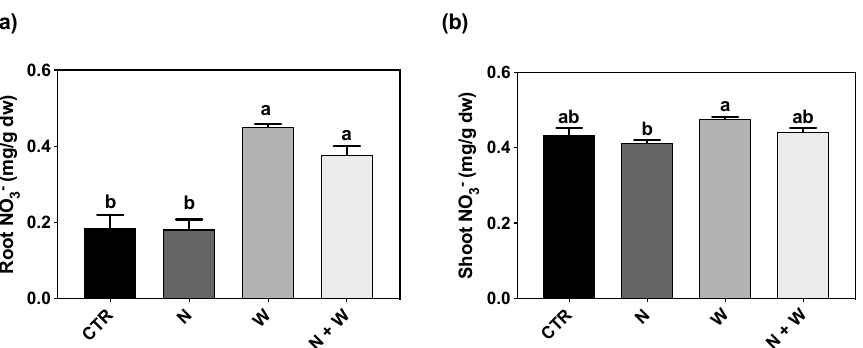
Figure 5. Nitrate (NO 3 − ) concentration in roots ( a ) and shoots ( b ) of tomato cv. Micro-Tom grown for 16 days under control (CTR; 10.5 mM N + 100% W), nitrogen deficit (N; 5.3 mM N + 100% W), water deficit (W; 10.5 mM N + 50% W) or combined nitrogen and water deficit (N+W; 5.3 mM N + 50% W). Data presented are mean ± SEM (n = 3). Different letters above bars indicate significant differences according to Tukey’s HSD test ( p = 0.05).